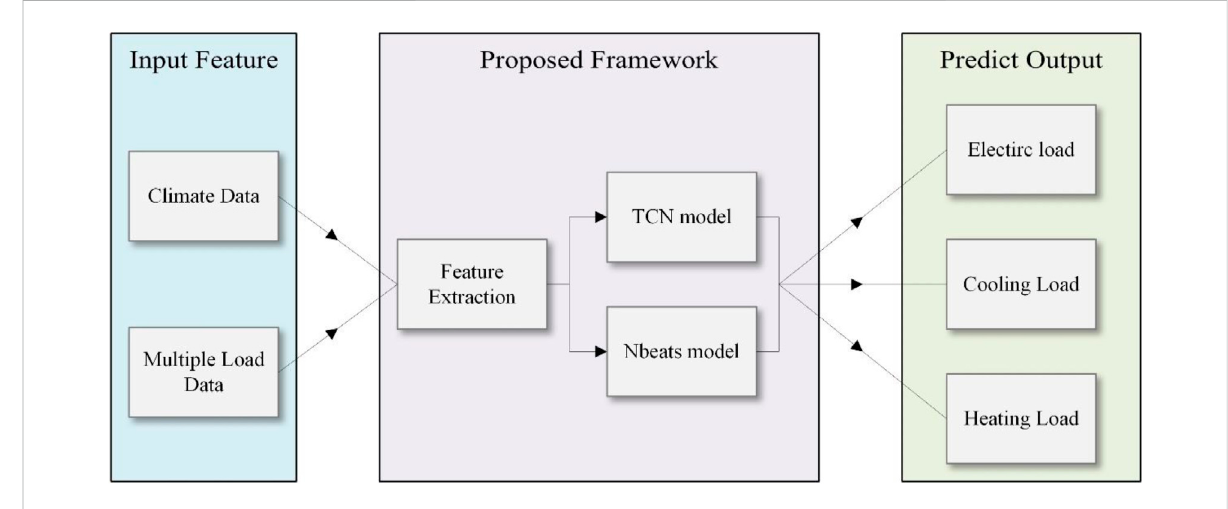
FIGURE 3 Schematic diagram of proposed forecasting model.